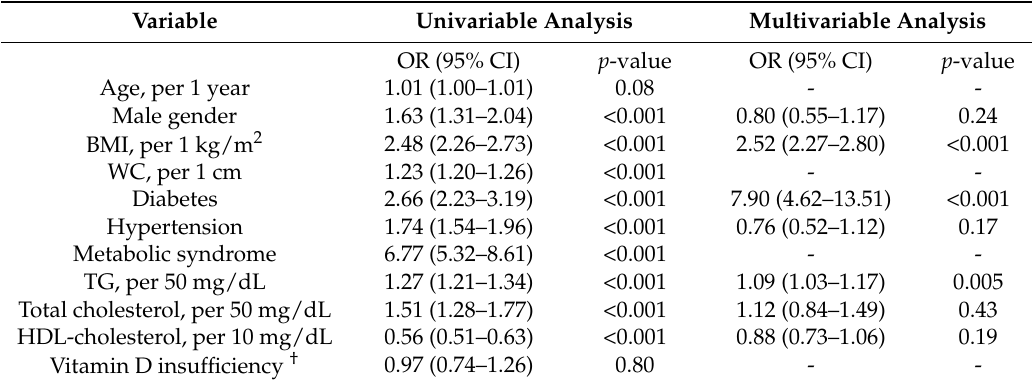
Table 2. Univariable and multivariable logistic regression analyses of baseline factors for the presence of nonalcoholic fatty liver disease